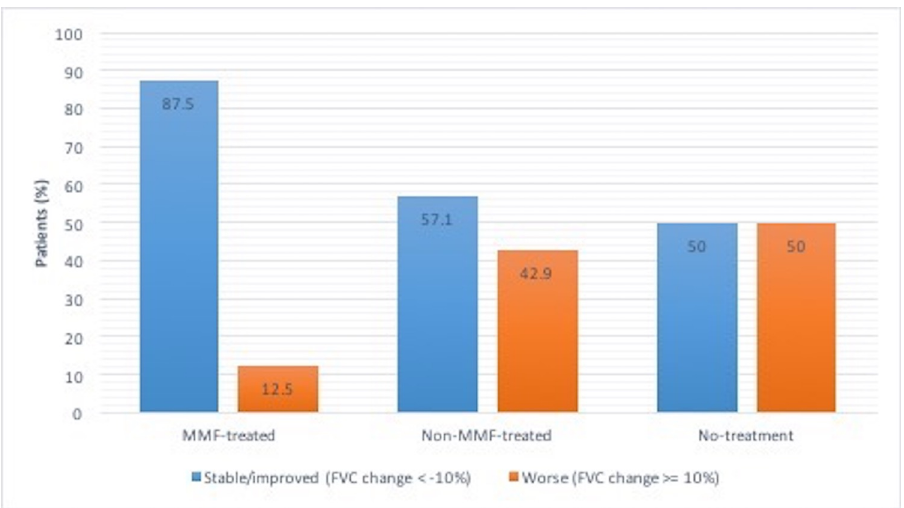
Fig 3. “Stable” versus “worse” FVC at 12 months by treatment group. p-value = NS using Fisher Exact test.